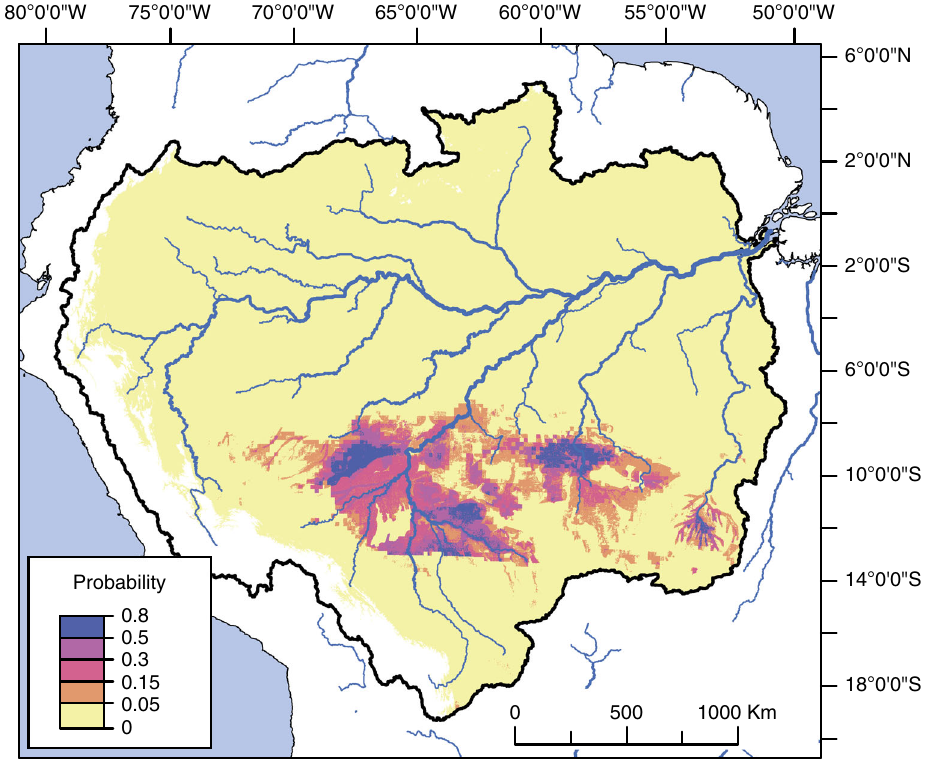
Fig. 6 Maximum entropy (MaxEnt) model of ditched enclosure distribution. The probability scale is given in the default logistic output of